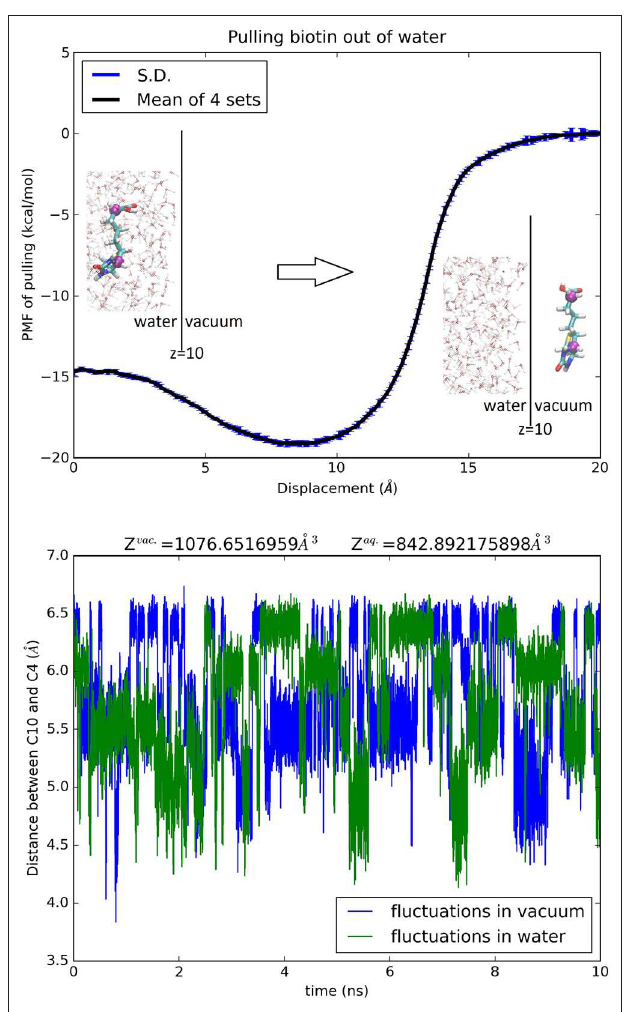
FIGURE 7 | Hydration of biotin. Top panel, the PMF of pulling biotin out of water. The error bars reflect the standard errors among four sets of samplings. The insets show the protonated, neutral biotin in water (left) and out of water (right). BTN is shown as licorices colored by atom names whose C4 and C10 atoms are shown as purple spheres indicating the two centers chosen in this study. The water-vacuum interface is at z = 10 Å. Some of the waters are shown in ball-and-sticks colored by atom names. The bottom panel shows the fluctuating distance between C4 and C10 in water and in vacuum.